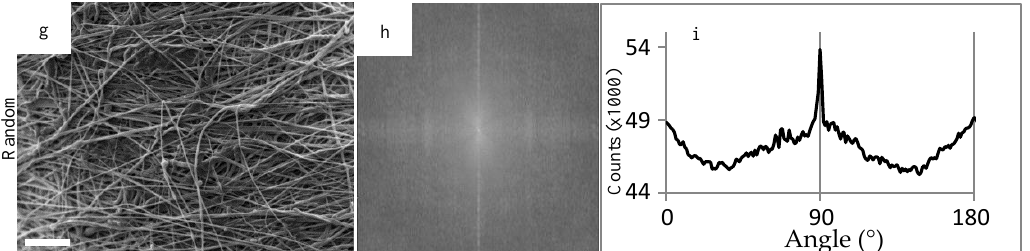
Figure 4. Fast Fourier transform (FFT) of representative scaffolds to demonstrate the tailorability in fiber alignment. FFT was used on ( a,d,g ) SEM images in order to gain the respective ( b,e,h ) FFT output images and ( c,f,i ) pixel intensity plots against the angle of acquisition. The alignment angle was determined through subtracting the peaks, resulting in ( a,b,c ) 5°, ( d,e,f ) 25°, and ( g,h,i ) random. Scale bar is 20 µ m.